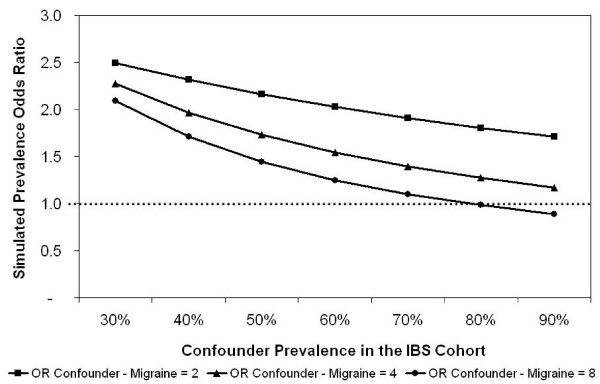
Sensitivity analysis of adjustment for an unmeasured dichotomous confounder on the prevalence odds ratio for migraine*. * Assumes a confounder prevalence of 20% in the non-IBS cohort.